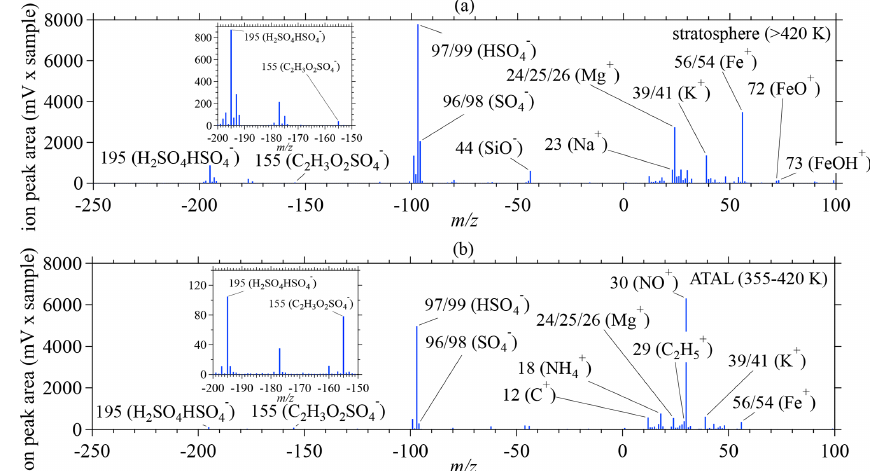
Figure 12. Bipolar mean spectra of the ERICA-LAMS particles containing organosulfates (here: glyoxal or glycolic acid sulfate evident by the abundance of m/z − 155 in single-particle spectra) in (a) the stratosphere above 420K potential temperature (averaged over 2354 particles) and (b) the ATAL between 355 and 420K (averaged over 11176 particles).